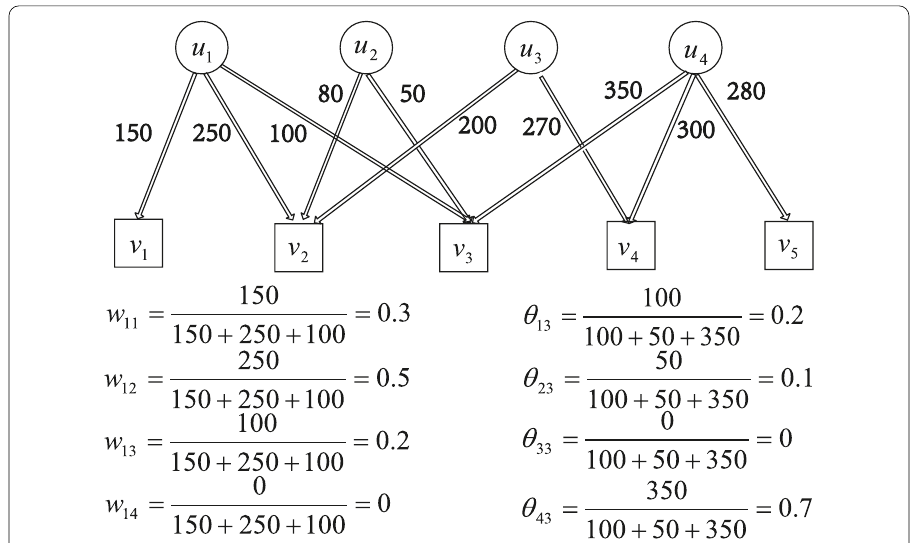
Fig. 3 An illustration of loan weight and lender weight (Four lenders and five loans are involved, ω 1 j , j = 1,2,3,4 is the loan weight of lender u 1 , and θ i 3 , i = 1,2,3,4 is the lender weight of loan v 3